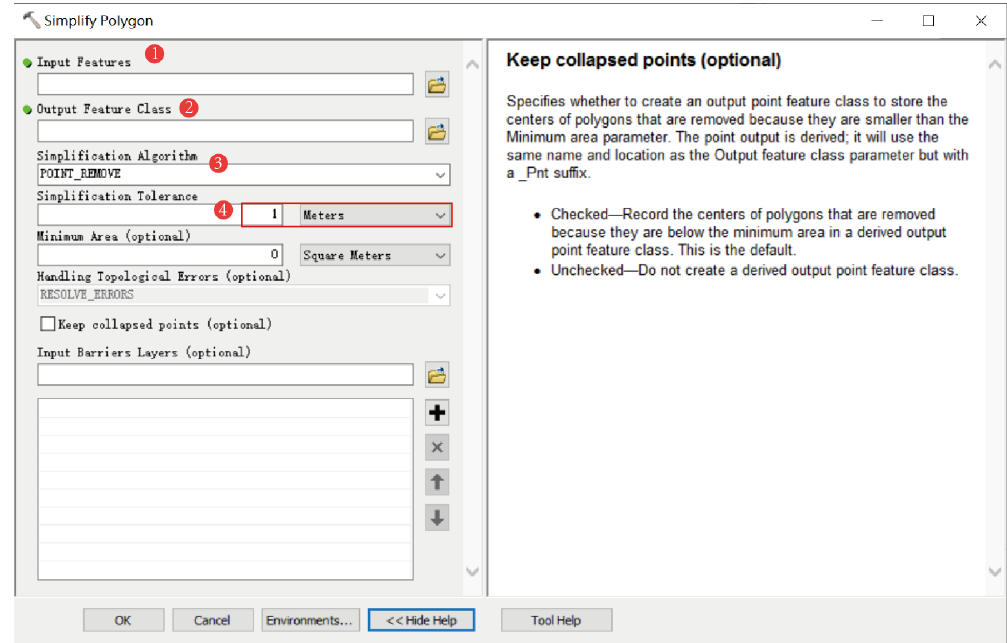
Figure A1. Input and option for Simplify Polygon in ArcGIS.